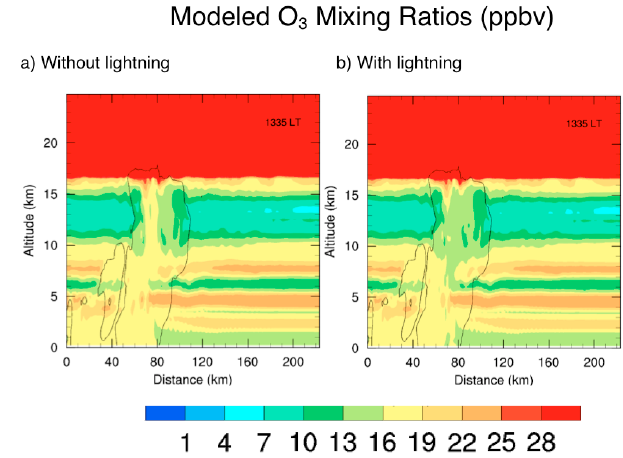
Fig. 18. Vertical distribution of percentage of lightning NO x mass per kilometer following convection at 15:35LT given 500molesNOflash − 1 .